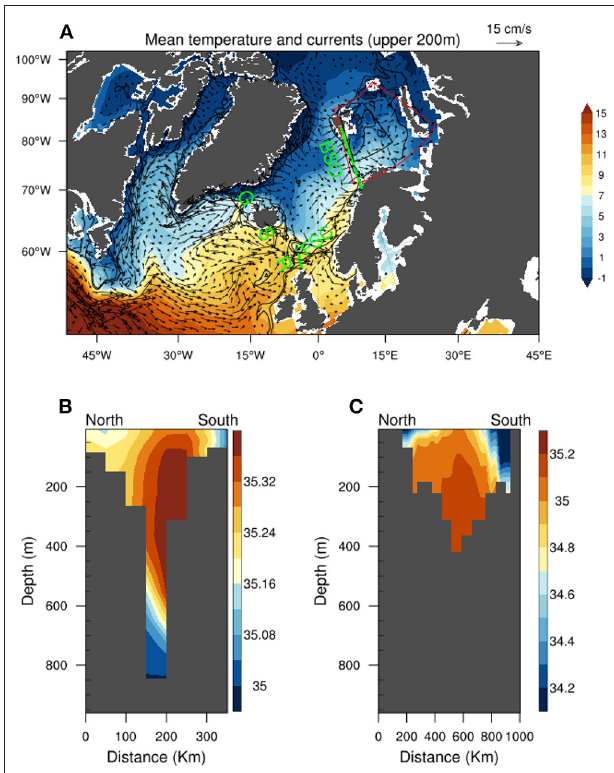
FIGURE 1 | (A) Mean (1960:2019 average) temperature and currents (upper 200 m) in the subpolar North Atlantic from the assimilation experiment. The black lines show 200 m and 500 m isobaths. Mean salinity at the hydrographic section at (B) Faroe Shetland Channel (FSC) and (C) Barents Sea Opening (BSO). The sections are shown as green lines in (A) . The Barents Sea regions analyzed in this study are defined as the black box (for wind stress curl) and red box (for Atlantic Water volume) in (A)